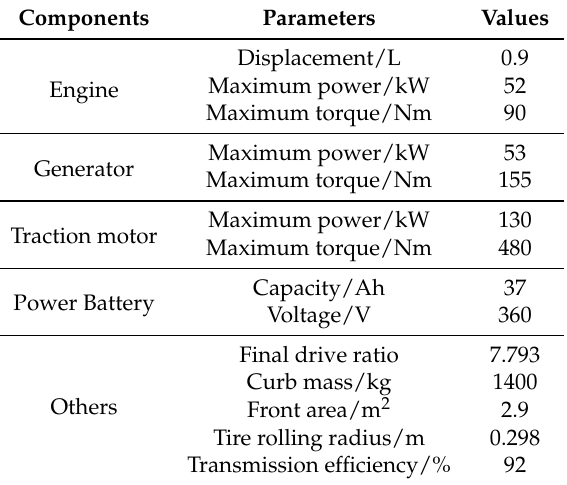
Table 1. EREV component